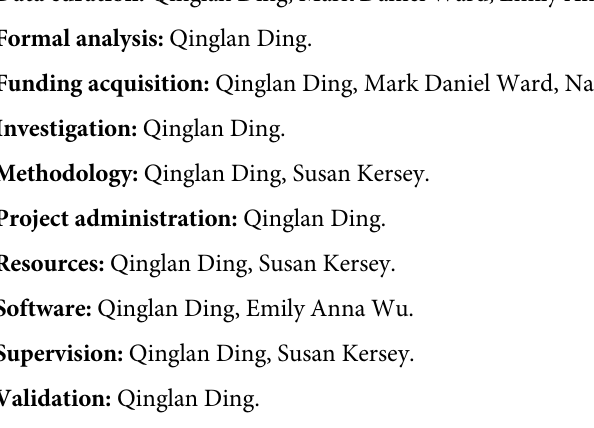
S12 Table. Checklist for Reporting Results of Internet E-Surveys